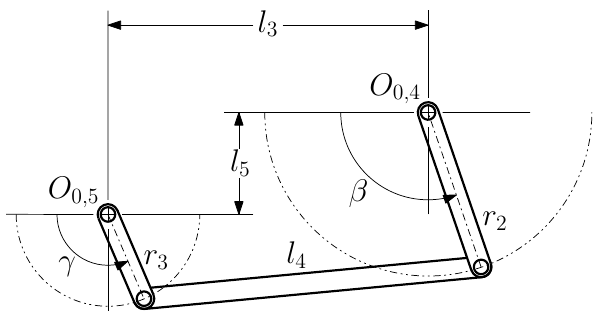
Figure 12. Linkage between the ring finger and the little finger